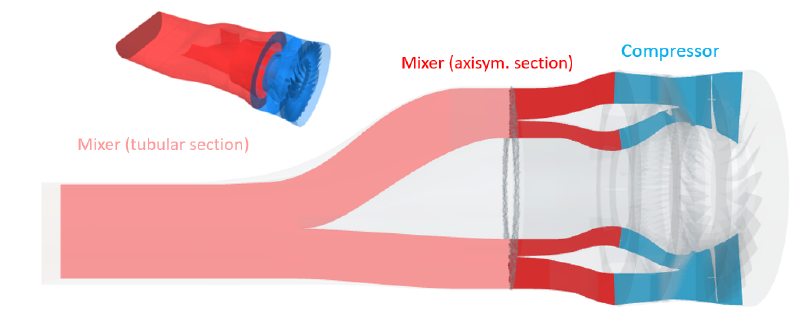
Figure 2. Geometry of the compressor and the